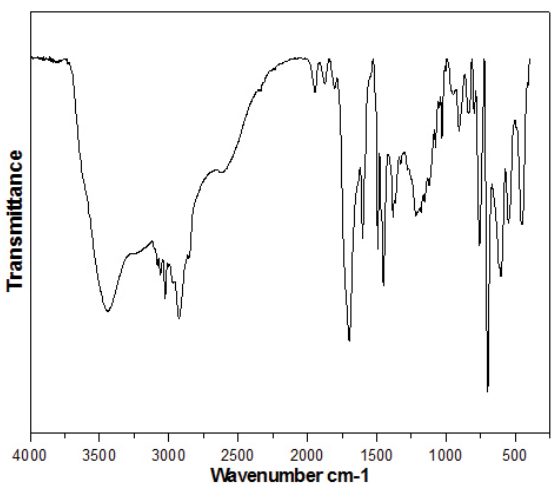
O /Poly(St-DVB-MAA) particle: (a)50×; (b)5000×. 2 3